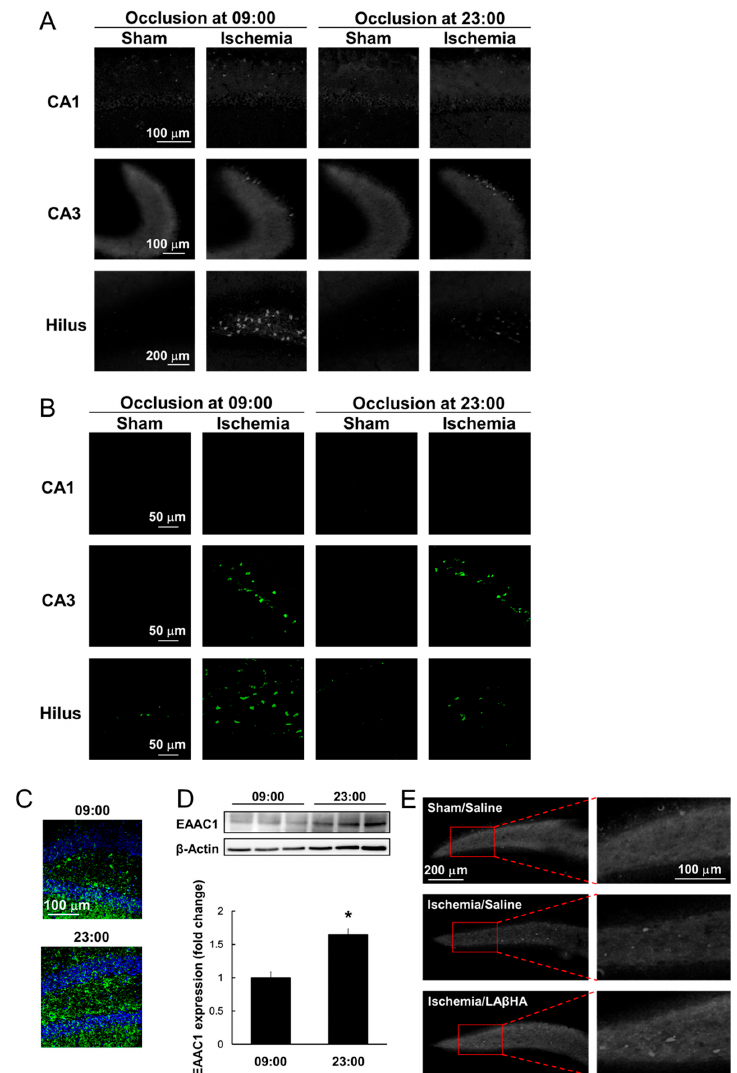
Figure 2. Reduced ischemia-induced Zn 2+ accumulation and neuronal injury in response to increased GSH levels via elevated EAAC1 protein expression at 23:00. ( A ) Representative images showing TSQ fluorescence (indicative of Zn 2+ accumulation) in the hippocampus 72 h after transient brain ischemia. Zn 2+ accumulation was observed in the CA3 and hilar but not the CA1 region in ischemic mice. Notably, the hilar Zn 2+ accumulation was remarkably reduced in mice subjected to transient brain ischemia at 23:00 compared to that at 09:00. ( B ) Fluorescent images showing neurodegeneration by Fluoro-Jade B staining in the hippocampus 72 h after transient brain ischemia in the CA3 and hilar but not in the CA1 region in ischemic mice. In the hilus, Fluoro-Jade B fluorescent signals were remarkably reduced in mice subjected to transient brain ischemia at 23:00 compared to those at 09:00. ( C ) Representative images depicting double immunofluorescence staining for glutathione adduct with N-ethylmaleimide (GS-NEM, represents GSH levels; green) and DAPI (blue) in the hilar region. GSH levels were significantly higher in the hilus at 23:00 than at 09:00. ( D ) EAAC1 protein expression was analyzed by Western blotting. EAAC1 protein levels in the hippocampus were significantly increased at 23:00 compared to at 09:00. * p < 0.05, relative to the hippocampus harvested at 09:00 (Mann-Whitney U test). ( E ) Representative images highlighting TSQ fluorescence in the hilar region 72 h after ischemia in mice pretreated with L-aspartic acid β -hydroxamate (LA β HA), a selective EAAC1 inhibitor, at 23:00. Ischemia-induced Zn 2+ accumulation was significantly increased in LA β HA-pretreated